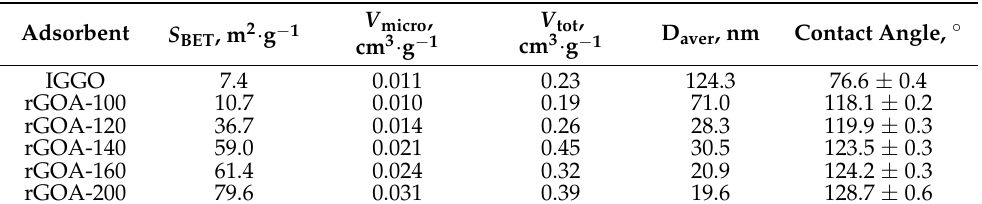
Figure 2. N 2 adsorption–desorption isotherms. Table 1. Textural properties and contact angles of the materials.